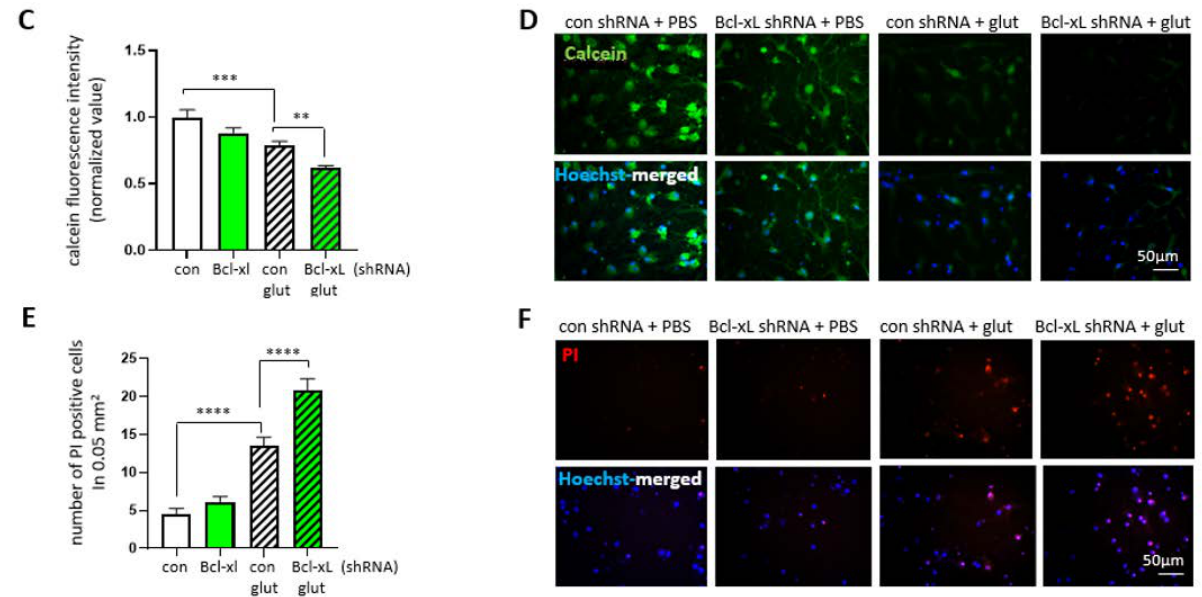
Figure 5. Bcl-xL depletion makes primary hippocampal neurons more susceptible to excitotoxicity. Primary hippocampal neurons transduced with control shRNA or Bcl-xL shRNA were treated with or without glutamate to induce excitotox- icity. Neurons were treated with Fluo-4 ( A , B ) to measure intracellular calcium concentration ( n = 121). ** p < 0.01 and **** p < 0.0001, Kruskal–Wallis test with Dunn’s multiple comparisons test. Calcein-AM and Hoechst staining ( C , D ) shows the proportion of healthy cells via fluorescent image analysis ( n = 100). ** p < 0.01, and *** p < 0.001, one-way ANOVA with a Tukey’s post-hoc-analysis. Scale bar = 20 µ m. PI and Hoechst staining ( E , F ) shows the proportion of dead cells